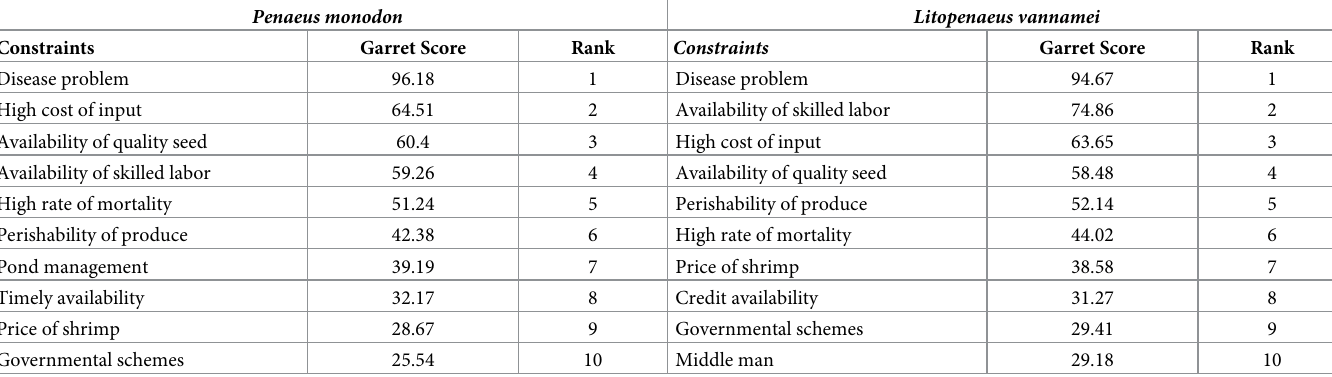
Table 10. Constraints militating against shrimp production among the